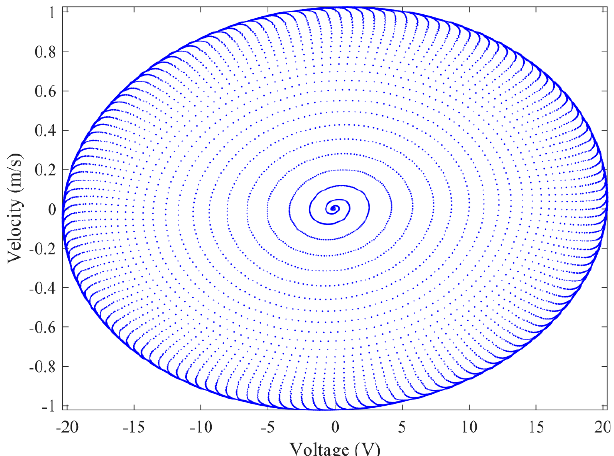
Figure 5. Phase portrait (limit cycle oscillation) ( U = 4.0 m/s).